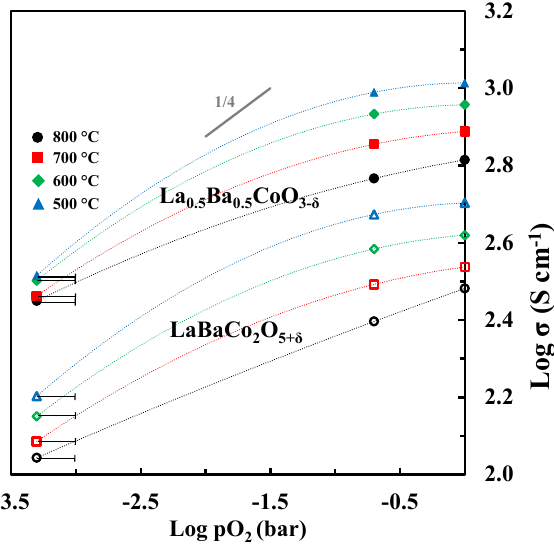
Figure 13. Log σ vs. log pO 2 for La 0.5 Ba 0.5 CoO 3 ‐δ and LaBaCo 2 O 5+ δ . At low pO 2 (N 2 ) the uncertainty in pO 2 is illustrated. The dotted lines are guides to the eye.